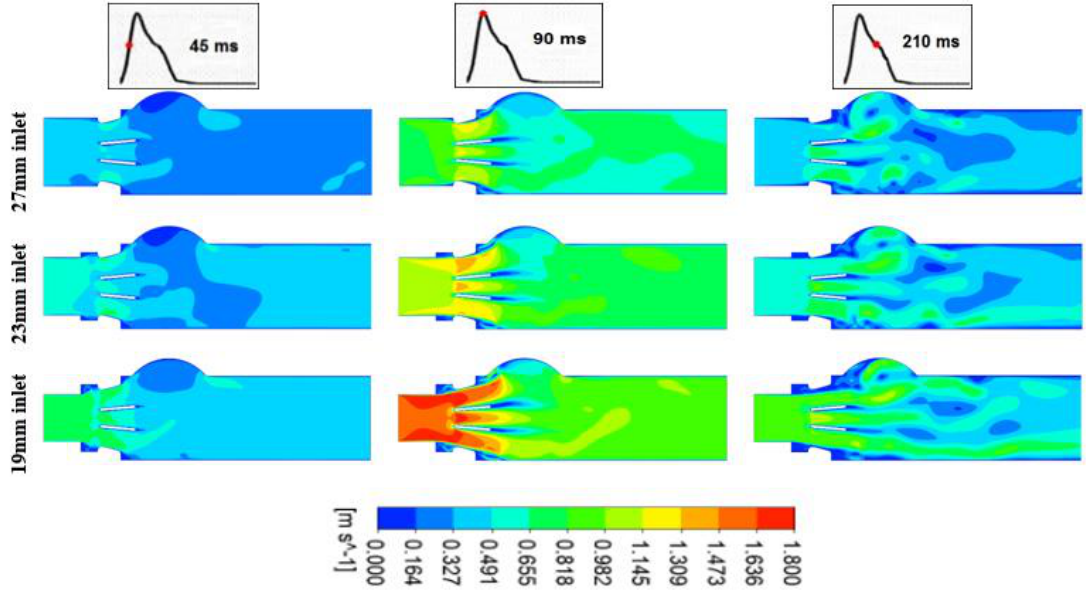
Figure 3. Velocity contours at three LVOT diameters (27, 23 and 19 m) at three different time instants (45 (acceleration phase), 90 (peak) and 210 ms (deceleration phase)) during the systole for normal BMHV at normal cardiac output (5 L/min).